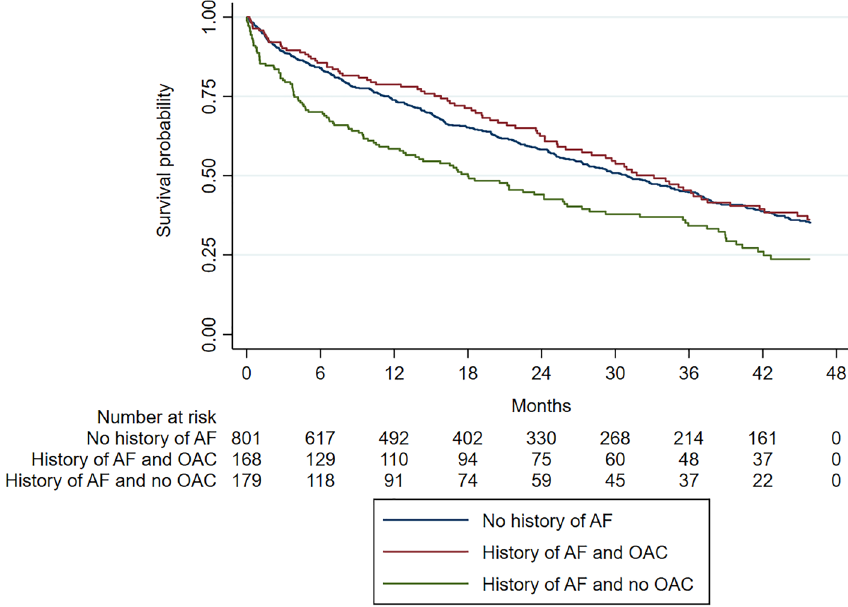
Figure 2. Death from any cause in patients with and without history of AF. AF, atrial fibrillation; OAC, oral